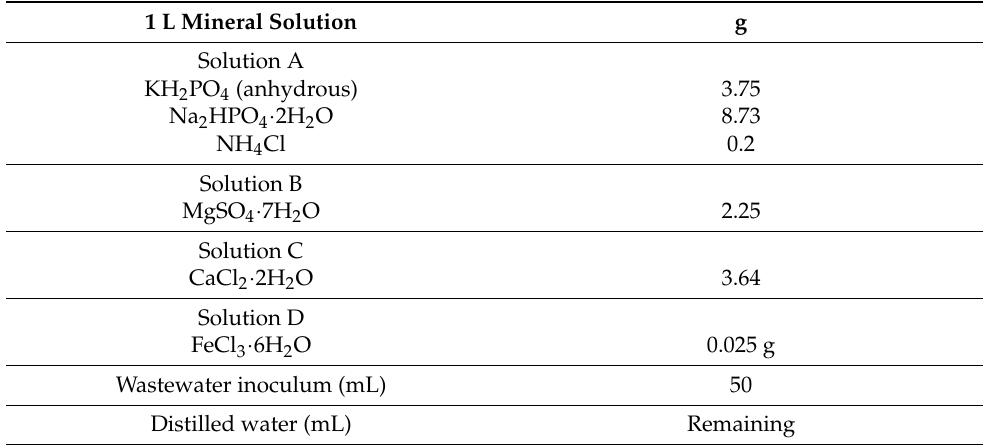
Table 3. Mineral solution composition for the